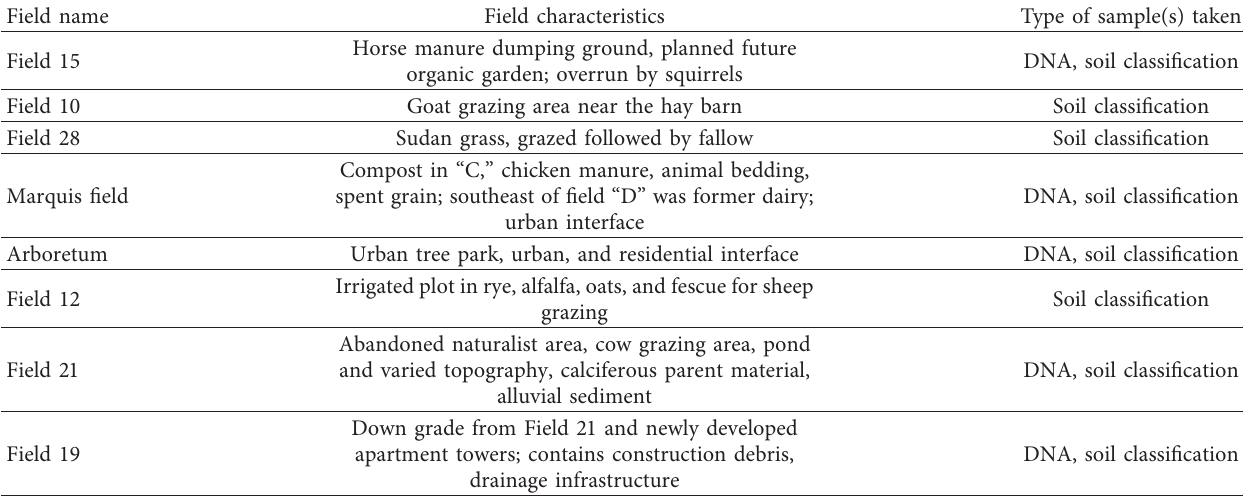
Table 1: Description of field characteristics and management practices at Pierce Farm.